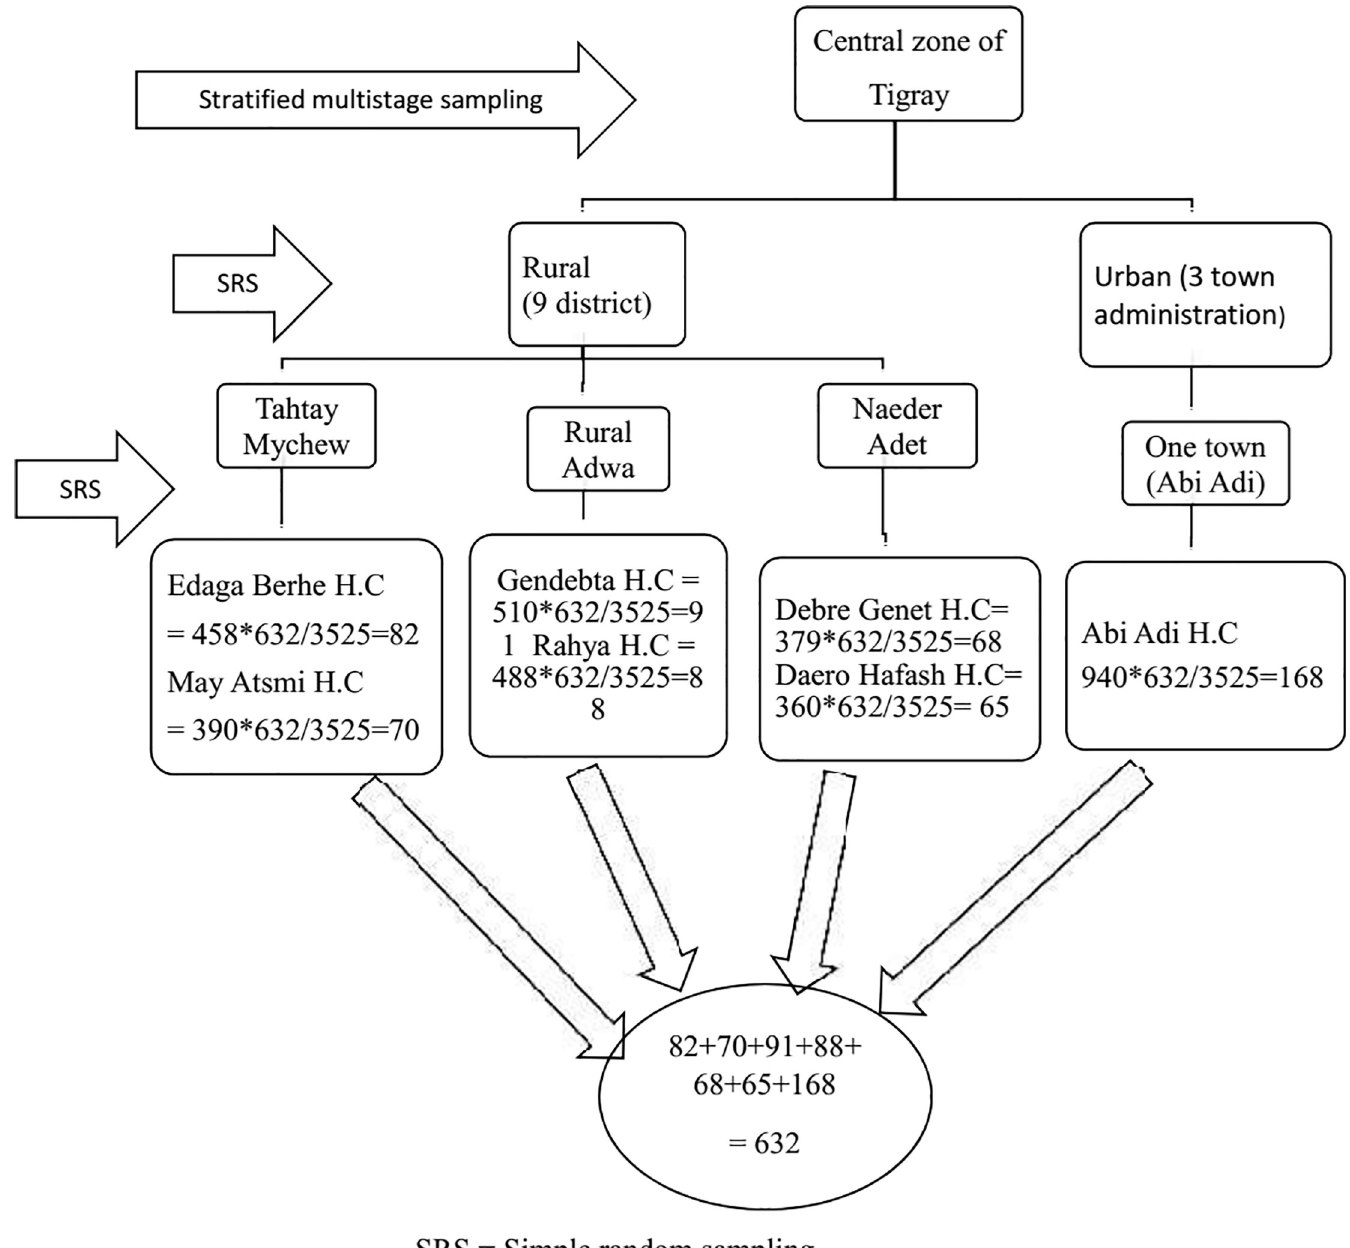
Fig 1. The schematic presentation of sampling